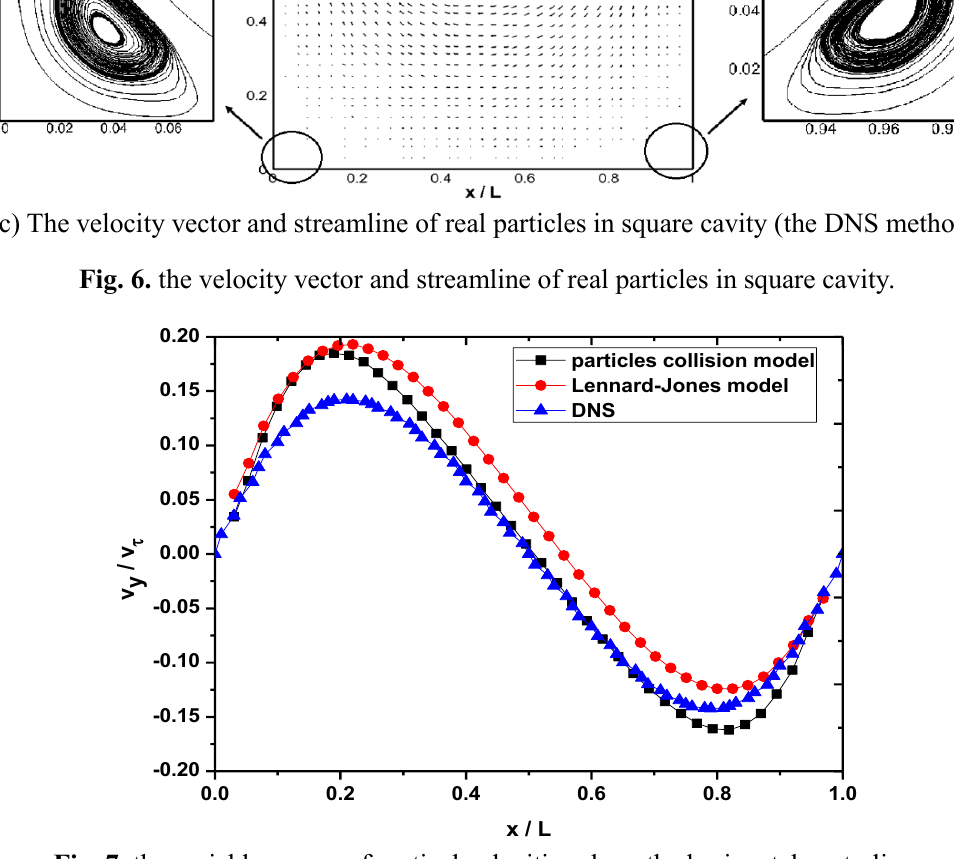
Fig. 7. the variable curves of vertical velocities along the horizontal